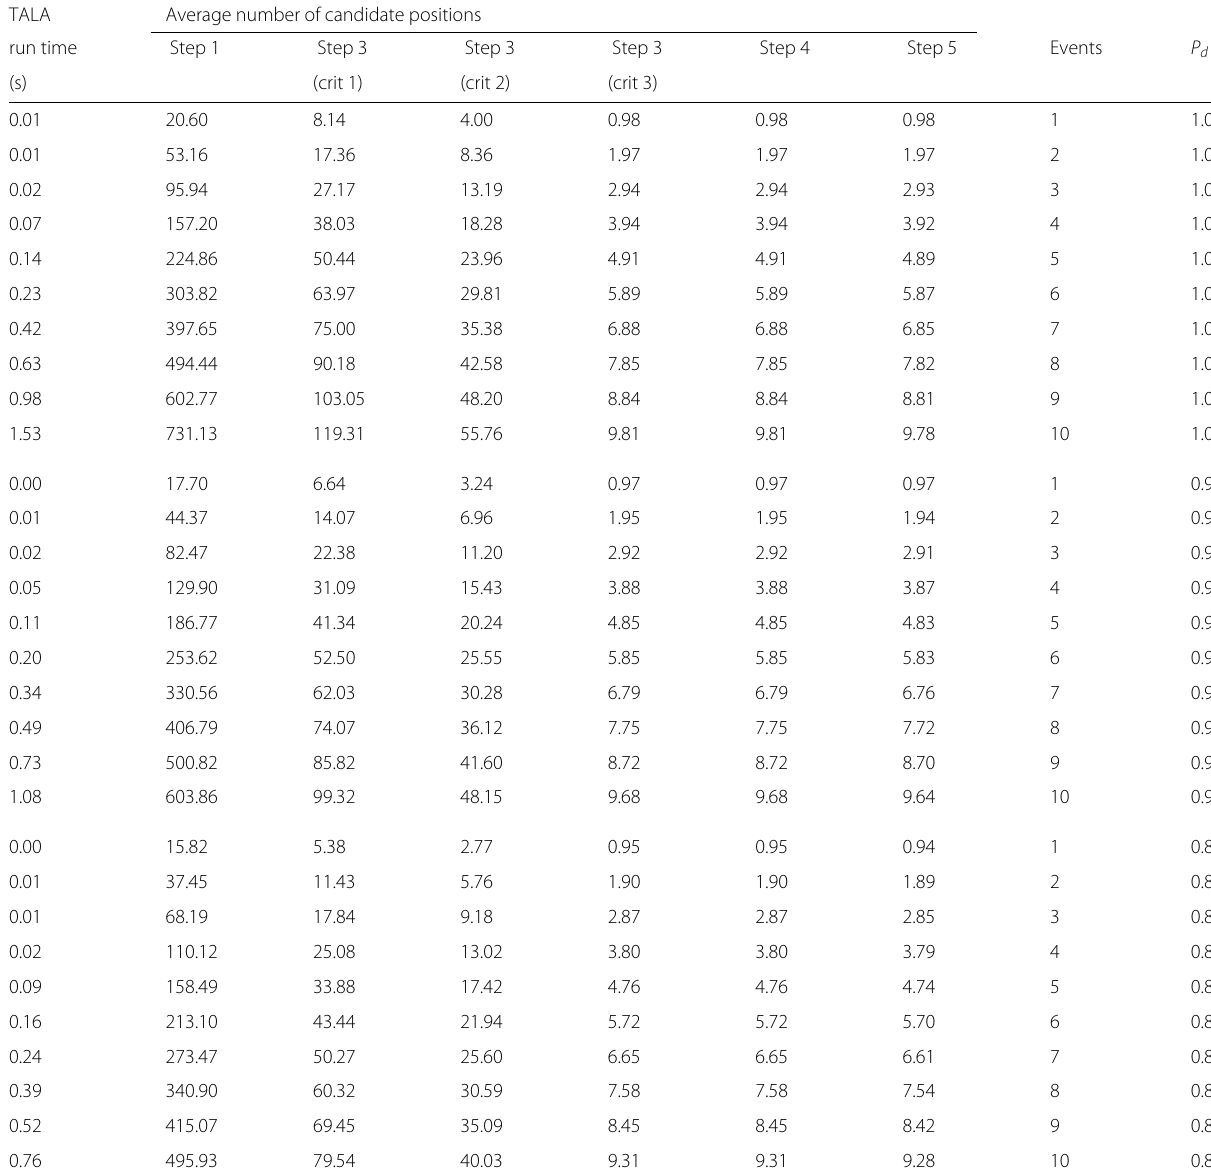
Table 6 TALA average computational time, and the average number of candidate locations at the end of each step of the TALA, for scenario